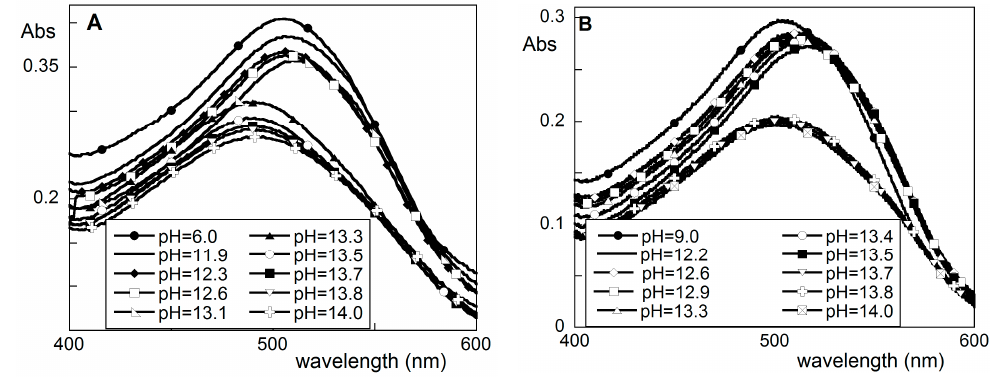
Figure 4. Absorbance spectra of Congo red (CR) in water solution of Sclg ( A ); and Sclg/borax ( B ) at different pH values.